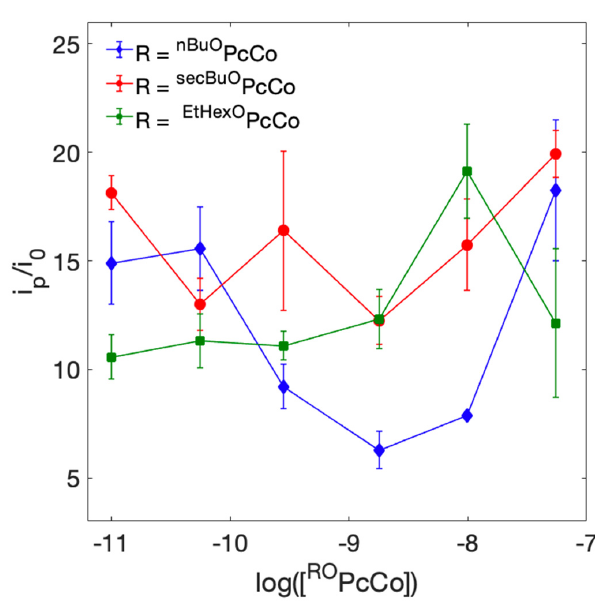
Figure 3. Ratio of current in the absence of CO 2 (i 0 ) to catalytic peak currents under 1 atm CO 2 (i p ) at each catalyst loading. The x-axis is the logarithm of the deposition concentration in mol cm − 2 . Blue diamonds = nBuO PcCo, red circles = secBuO PcCo, and green squares = EtHexO PcCo.